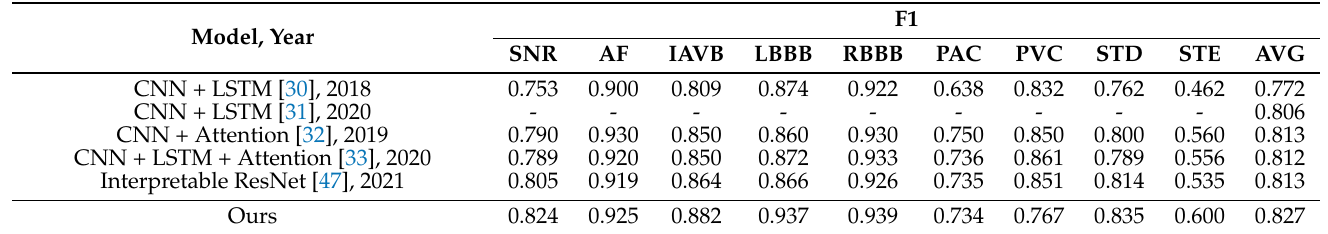
Table 5. Comparison for classification performance of previous works and ours evaluated on the recommended test set of